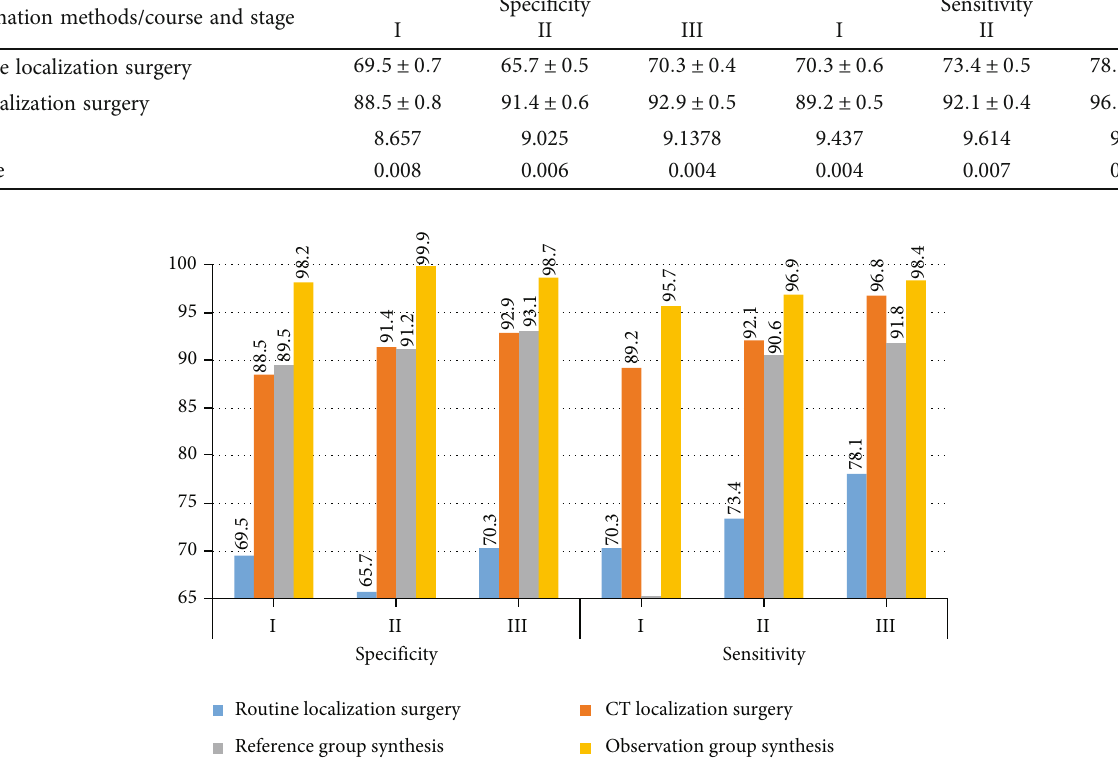
Figure 2: Visual diagram of the surgical methods for patients with pulmonary nodules. Table 3: Comparison of the observation results of prognosis and quality of life of di ff erent examination methods (data source: self-statistics of the